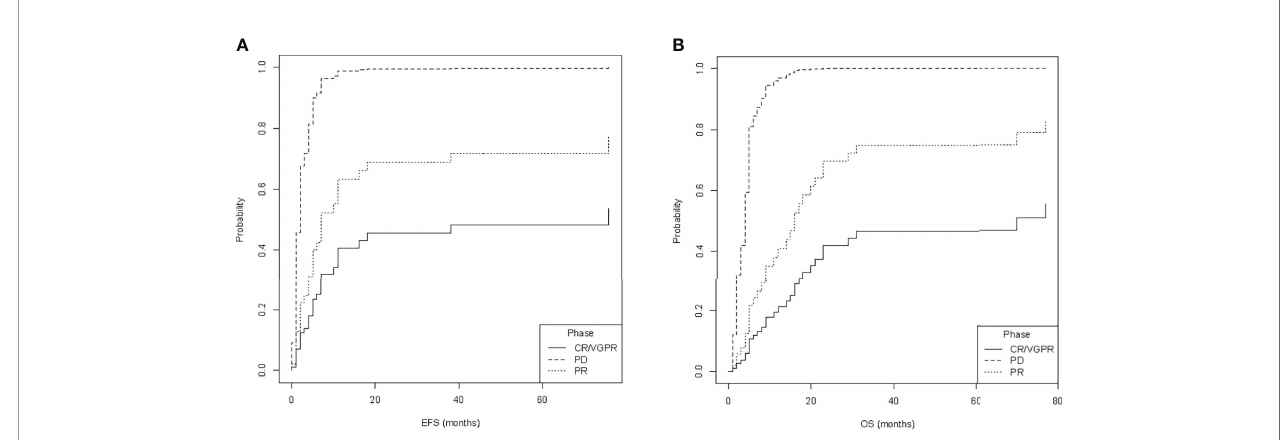
FIGURE 3 | Estimated cumulative incidence of (A) relapse and (B) death, depending on the status at allogeneic hematopoietic stem cell transplantation (phase at allo-HSCT), namely, complete response or very good partial response (CR/VGPR), partial response (PR), and progressive disease (PD). Data of event-free survival (EFS) and overall survival (OS) were used for